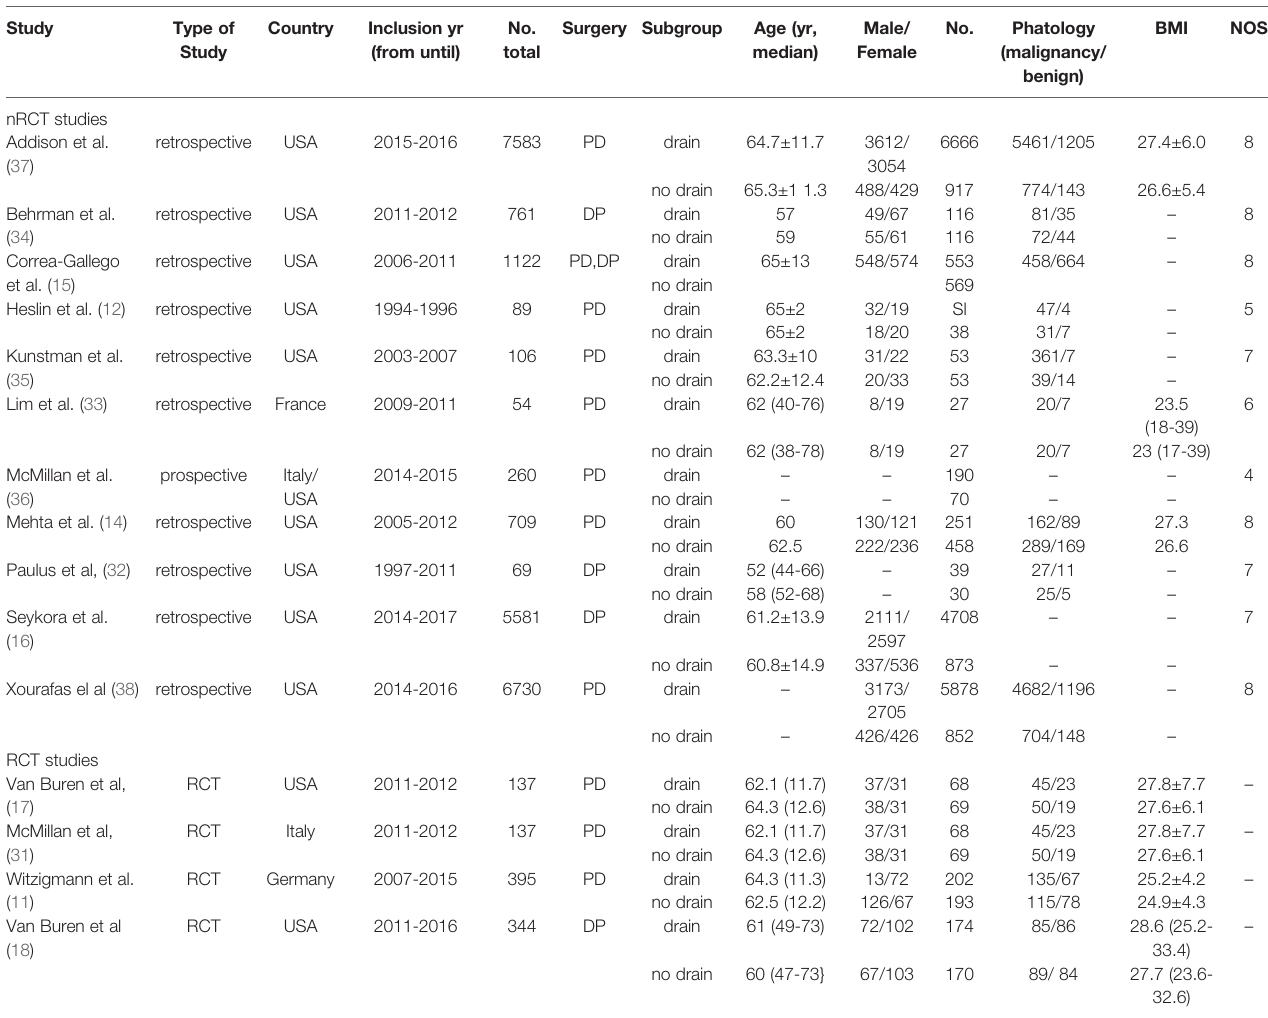
TABLE 1 | Characteristics of studies